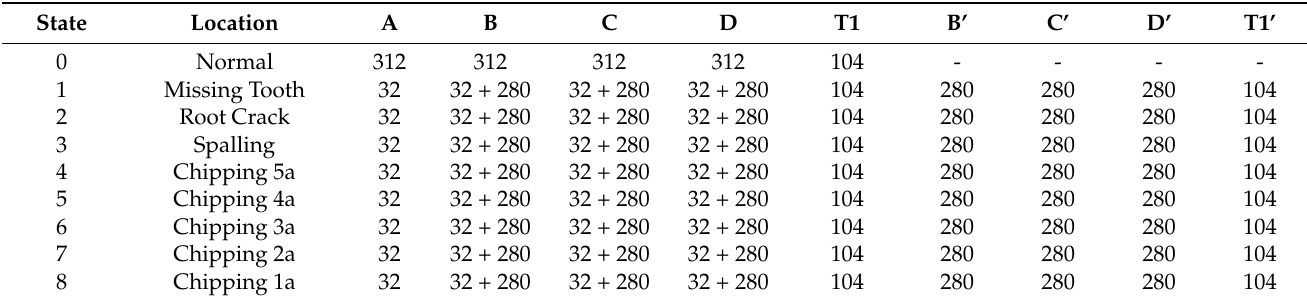
Table 4. The details of experimental datasets, based on Case 1.